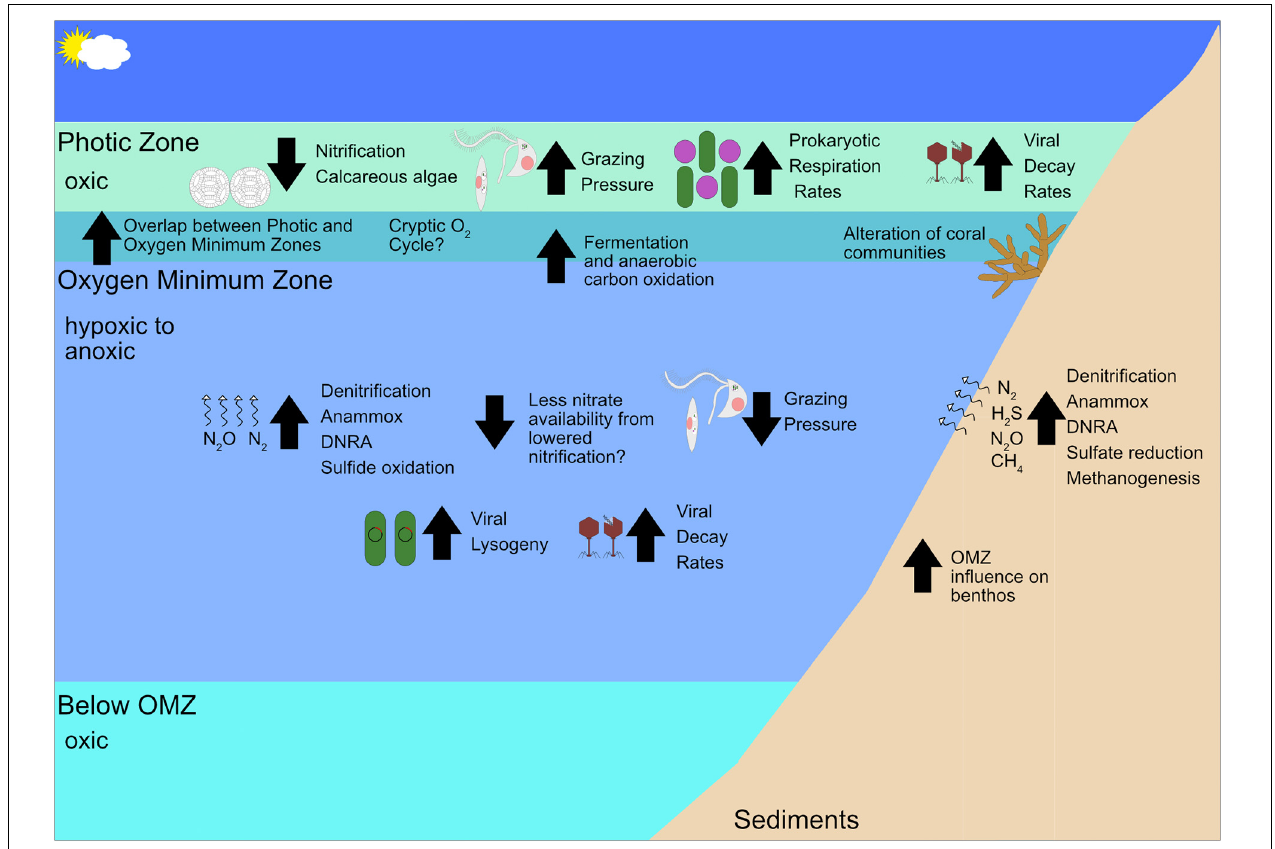
FIGURE 3 | Schematic of how future deoxygenation may affect the ecology of OMZs and their adjacent areas. Upward pointing arrows indicate the process or organisms whose abundance/rate is expected to increase, not considering biotic interactions and feedback loops by climate change and downward pointing arrows indicate negative